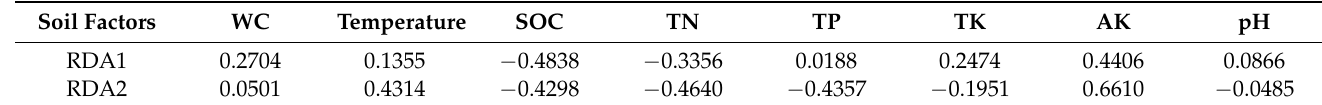
Table 3. RDA sorting axis correlation of soil factors with bacterial communities. Soil